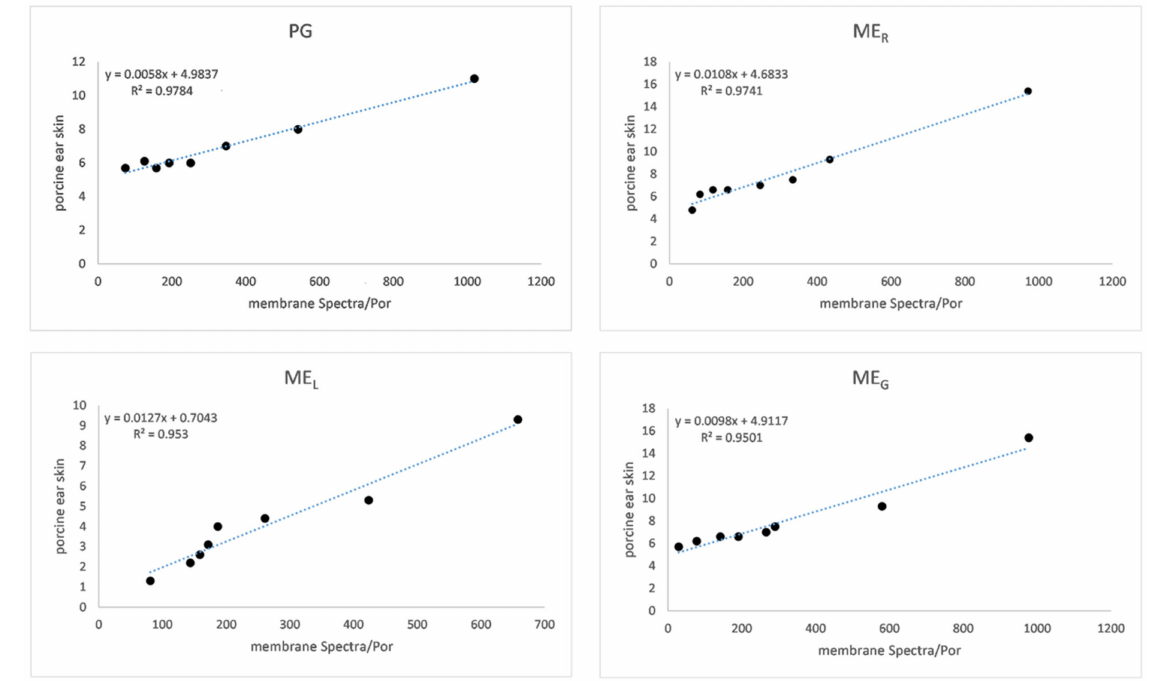
Figure 5. The correlation between in vitro and ex vivo MXD release (10 − 2 µ g · cm − 2 ) from sodium alginate gel through membrane Spectra/Por ® and porcine ear skin. Propylene glycol (PG), reference ME R , lecithin-containing ME L , gelatin- containing ME G